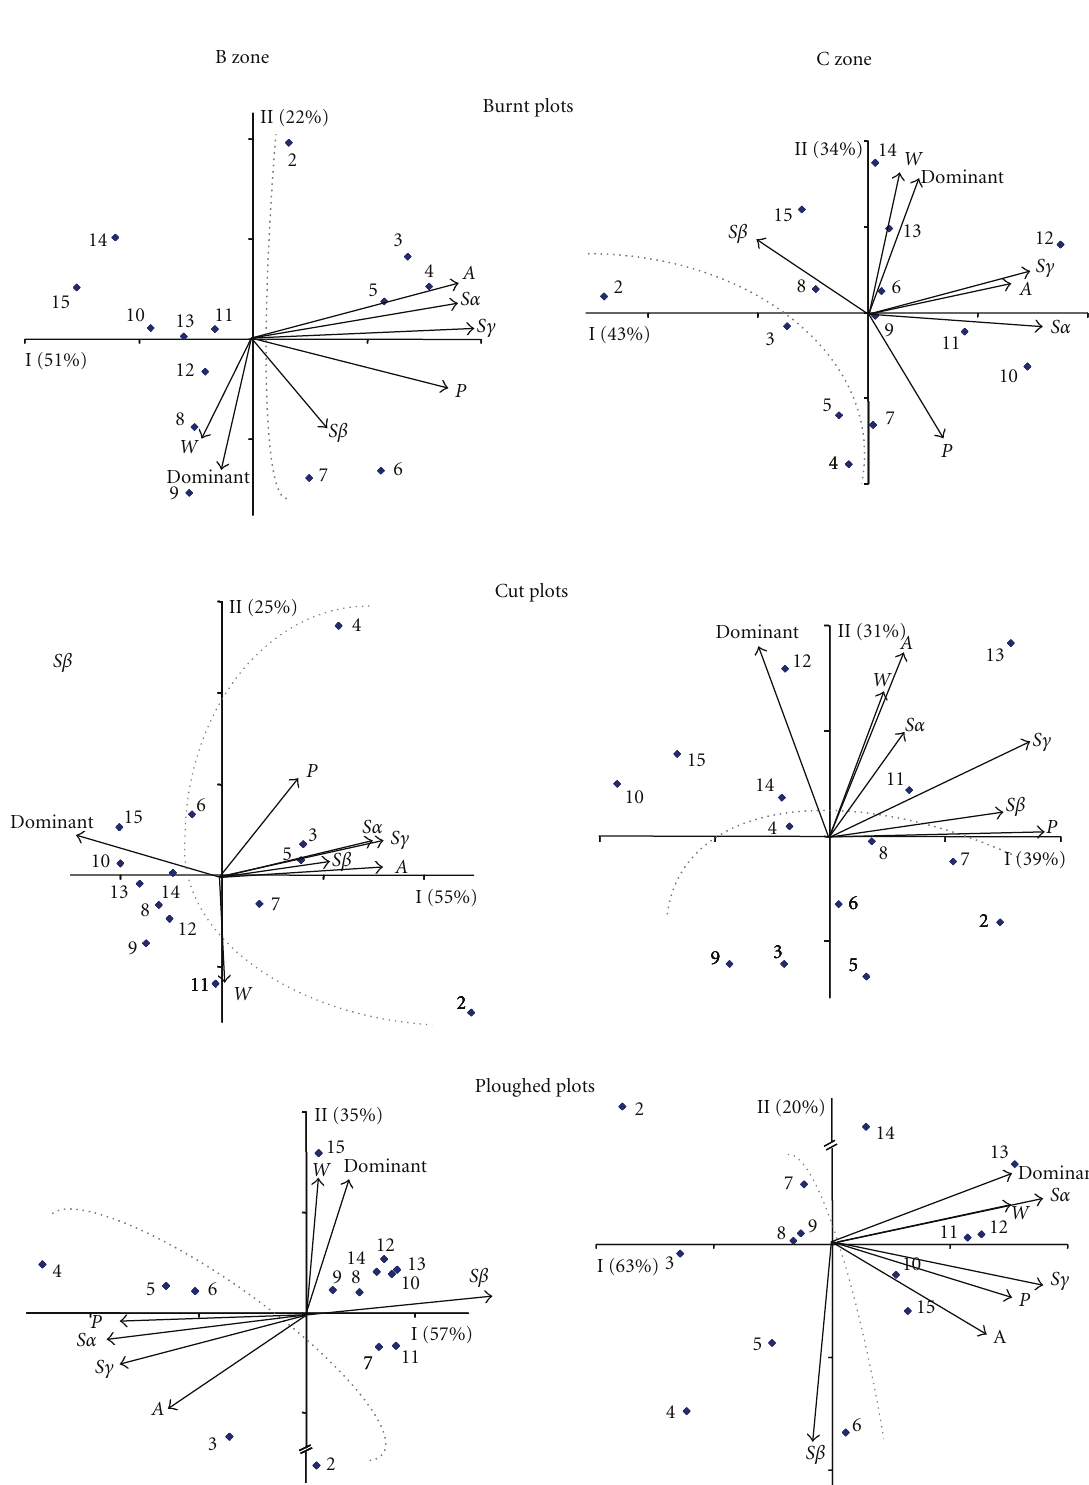
Figure 6: Location of variables and samples in the plane defined by the two first axes of the principal components analysis carried out with data from the three plots in zones B and C. (Annual herbaceous species number ( A ), perennial herbaceous species number ( P ), woody species number ( W ), S α , S γ , S β , and cover of dominant species (Dom.).) Numbers representing years after experimental